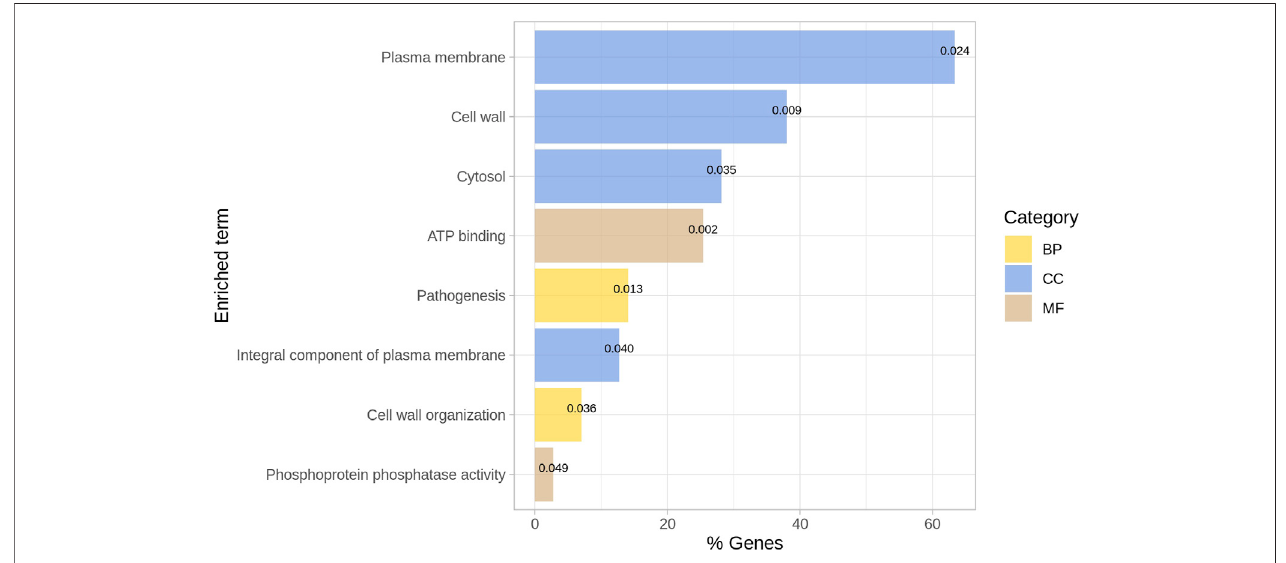
FIGURE 4 | Enriched GO terms for outliers. The p -value is indicated for each term. BP = Biological process; CC = Cellular Component; MF = Molecular